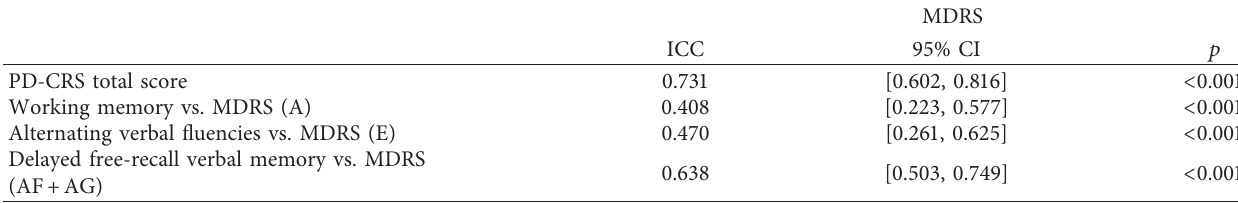
Table 4: Validity of PD-CRS.